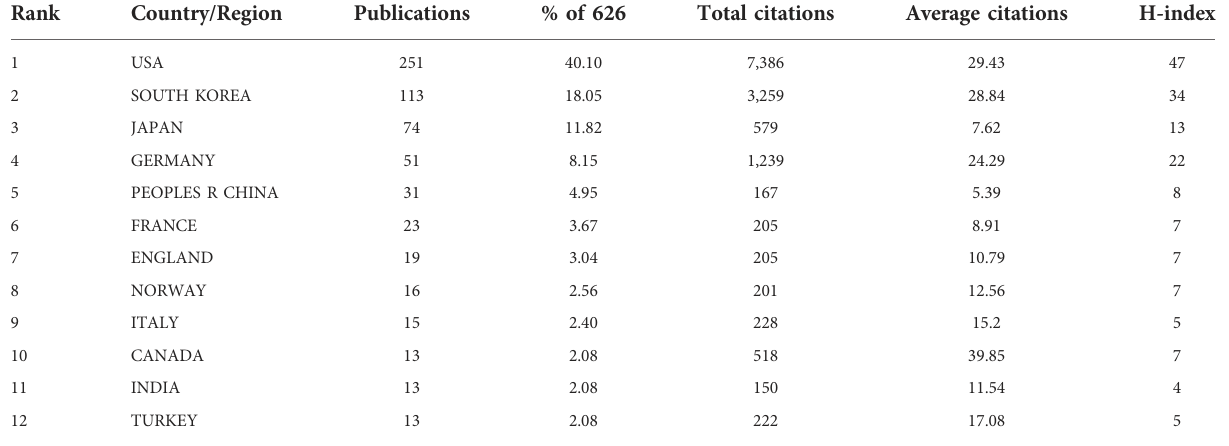
TABLE 1 The top 10 countries/regions by publications, citations and